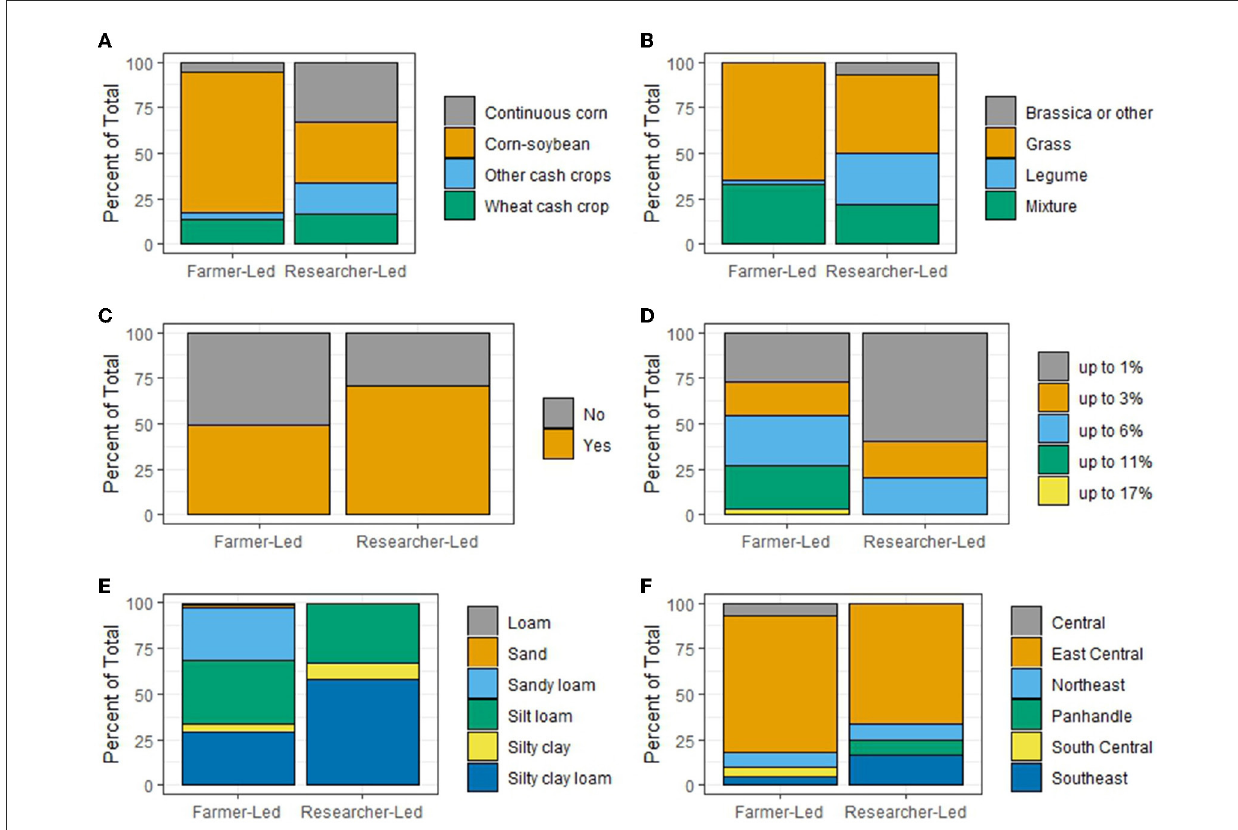
FIGURE2 Management and environment information [ (A) crop rotation, (B) cover crop species, (C) irrigation, (D) field slope, (E) soil type, and (F) Nebraska region] in farmer-led ( n = 89) and researcher-led ( n = 290) trials. The bar graph shows the percentage of studies or observations out of the total number of studies reporting information for each